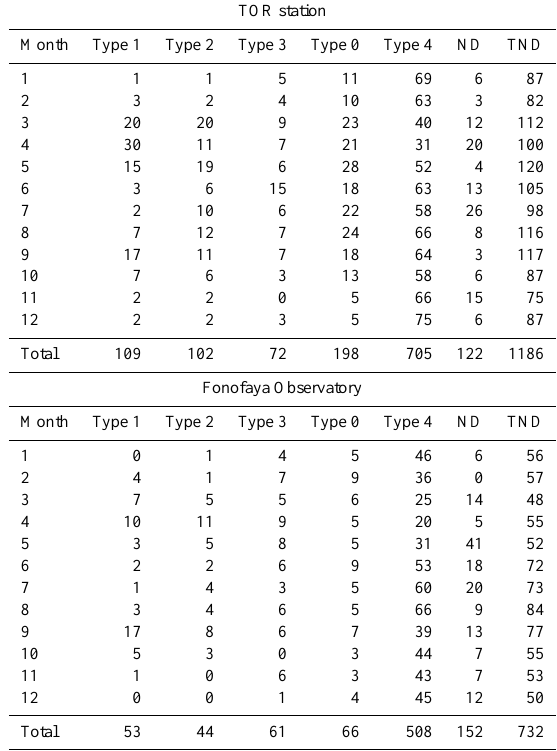
Table 4. Total number of days when nanoparticles formed in situ (Types 1, 2, and 3), type was uncertain (Type 0), and no nucle- ation (Type 4) was observed over the entire measurement period. ND means no data available, i.e., days when the instrumentation did not work for any reasons; TND means the total number of days